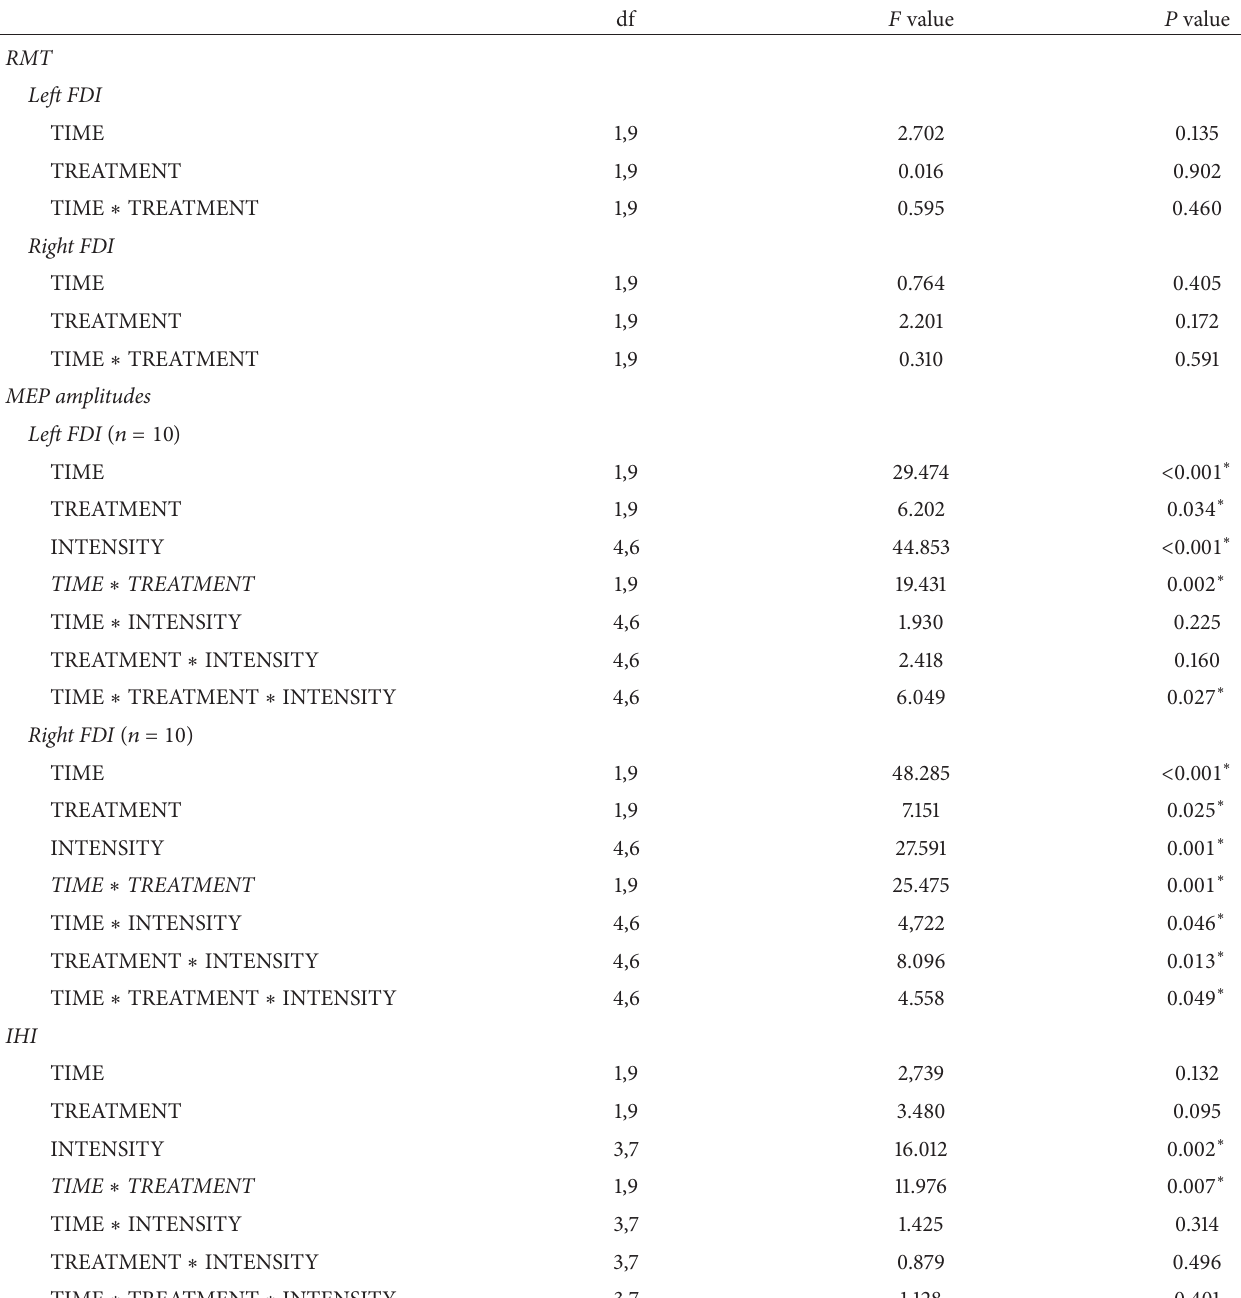
Table 1: General comparisons by two-way/three-way repeated-measures ANOVA on TMS measures of cortical excitability from both hemisphere and IHI. df 𝐹 value 𝑃